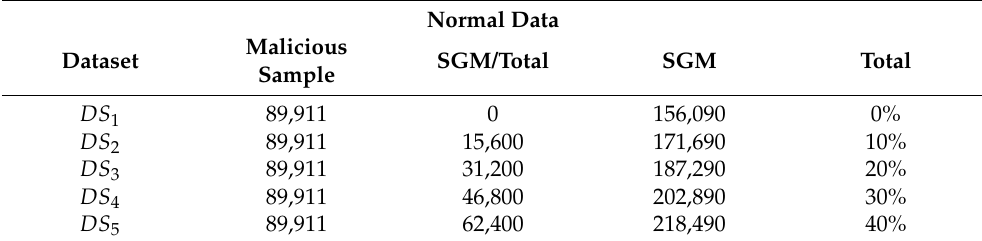
Table 4. The statistics of Sample